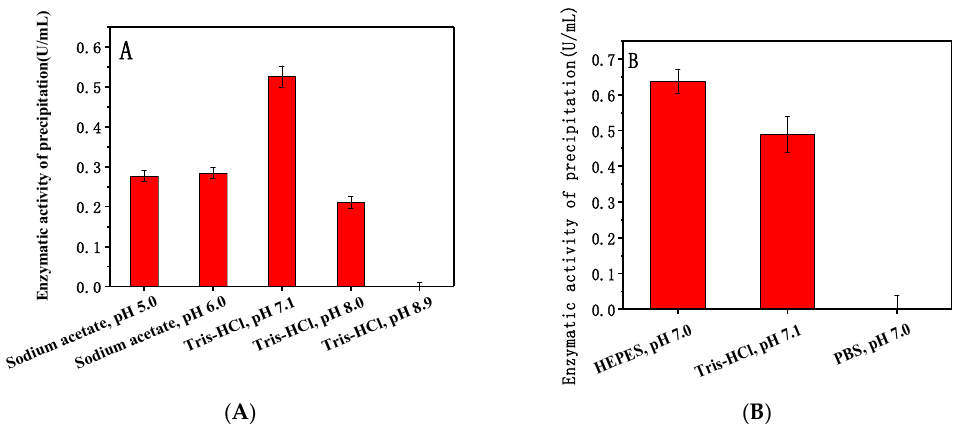
Figure 1. Effect of different pH buffers on the adsorption of dextranase onto Mg/Fe-LDH ( A ) pH 5.0–8.9; ( B ) pH 7.0.